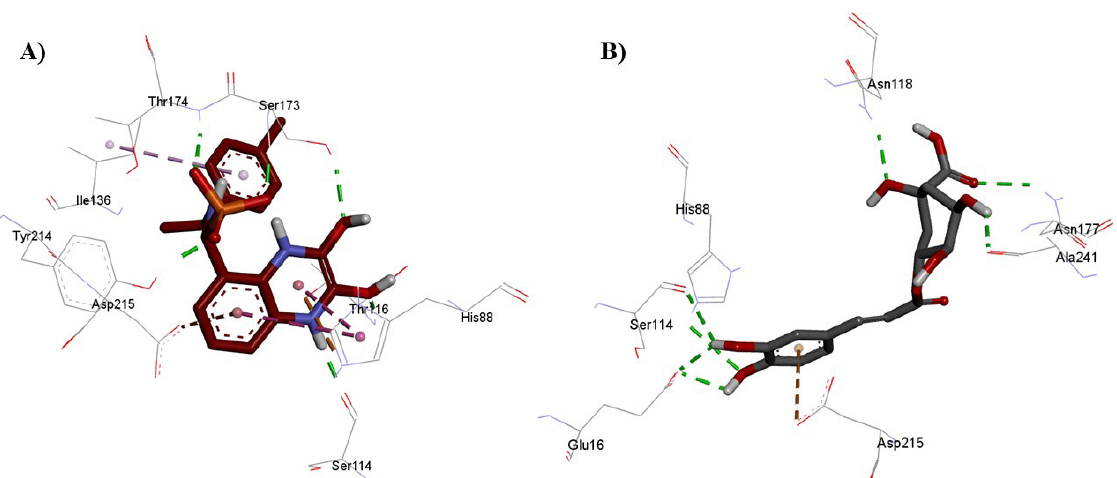
FIGURE 4 - The binding interactions between the ligands and NMDA receptor. A) PEAQX B) Chlorogenic acid. Hydrogen bonds are presented by green, Pi-alkyl by pink, Pi-cation/anion by orange, and Pi-Pi stacking interactions by magenta dotted